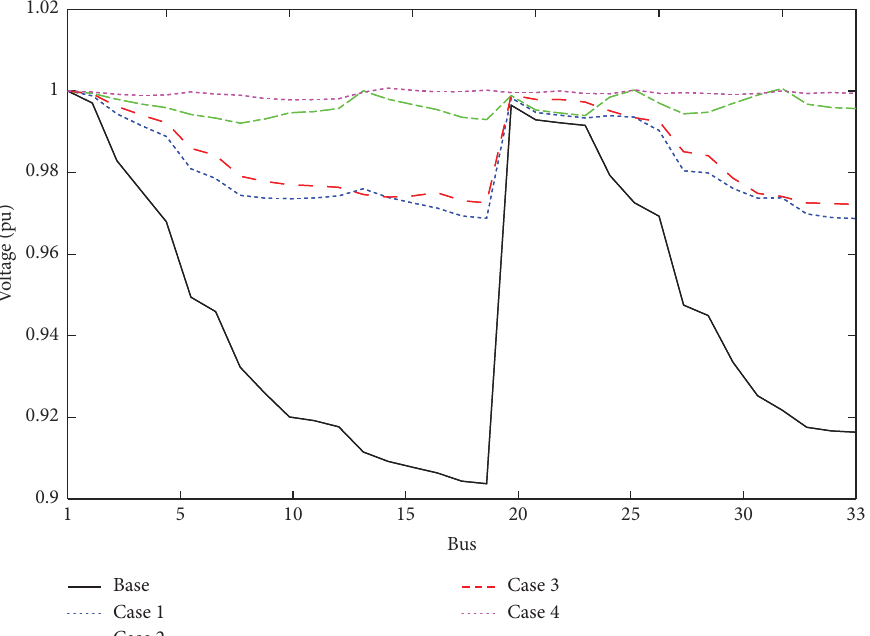
Figure 9: Comparison of voltage profles for system 1.